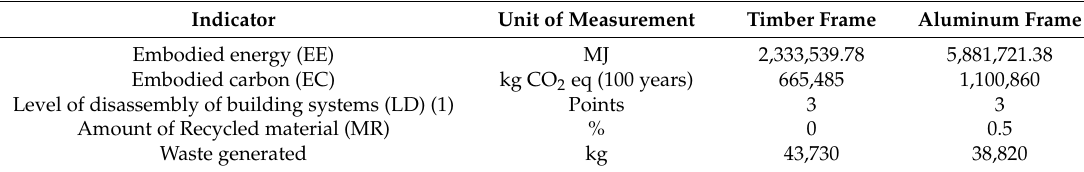
Table 8. Summary of the value of environmental indicators.